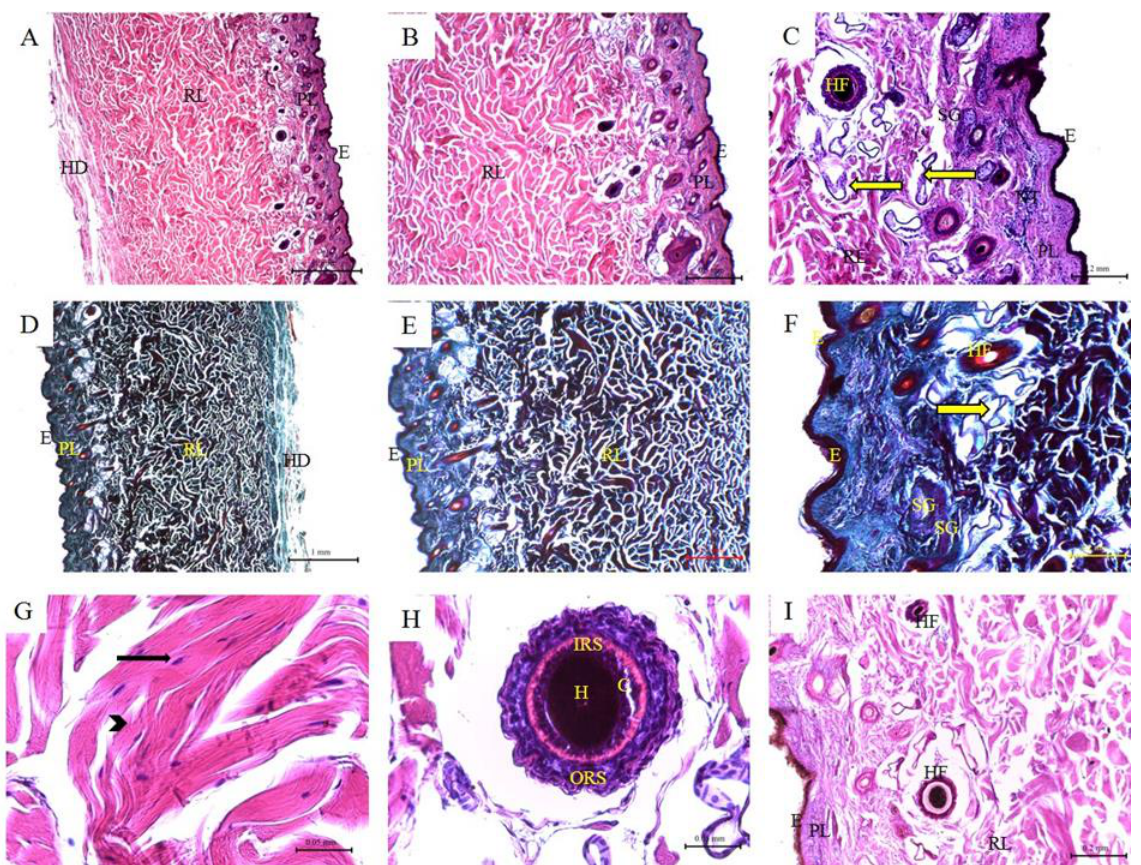
Figure 2: Histological features of cow skin. Hematoxylin and eosin staining ( A-C ; G-H) ; Crossman's trichrome staining ( D-F) ; and PAS staining ( I ) of cow skin tissue sections. (E) Keratinized stratified squa- mous epithelium of the epidermis; (PL) Papillary layer of the dermis; (RL) Reticular layer of the dermis; (HD) Hypodermis; (SG) Sebaceous glands; (Black arrow) fibrocytes; (Arrow heads) collagen bundles of the reticular layer; (Yellow arrow) Sweat glands; (HF) Hair follicles; (H) Hair; (C) Cuticle; (IRS) Inner root sheath; (ORS) Outer root